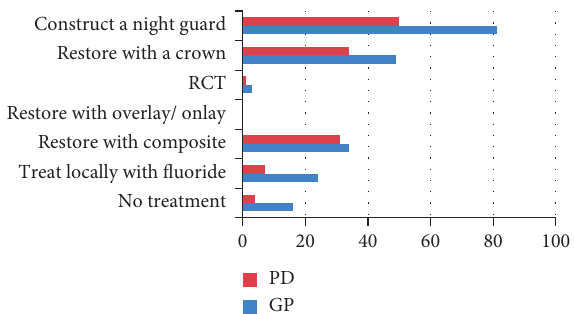
Figure 8: Frequencies of treatment decisions among GPs (general practitioners) and PDs (prosthodontists) regarding case